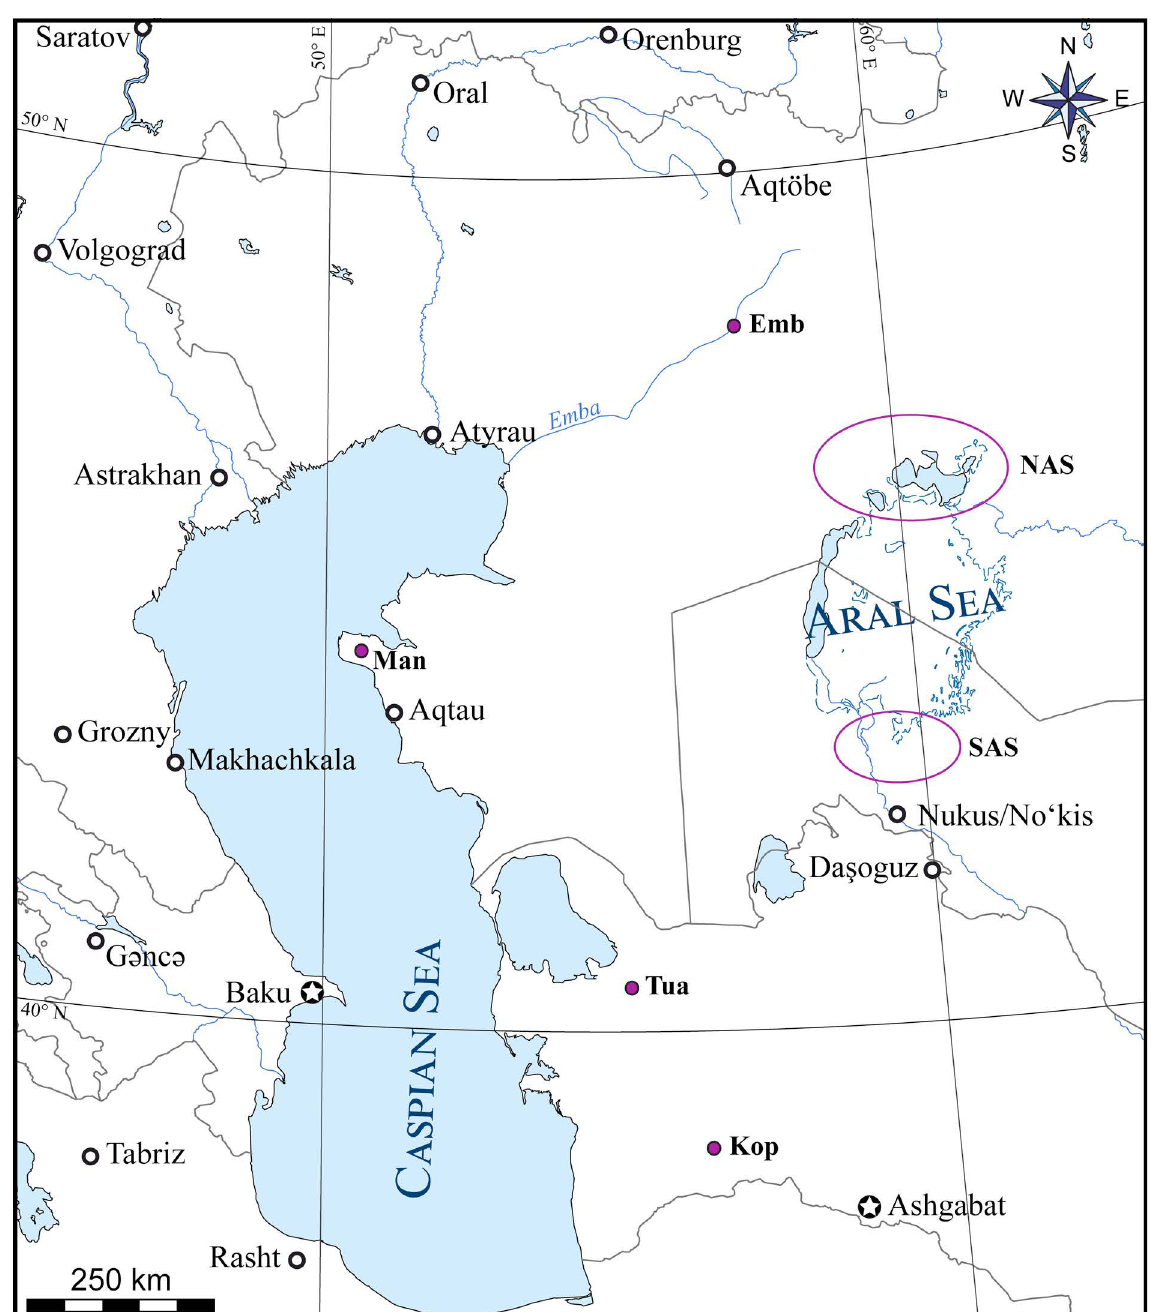
Fig. 2. Map of the Caspian and Aral seas region showing localities of bryozoan material examined or mentioned in this study. Abbreviations: Emb = Emba River, Aqtöbe Region, Kazakhstan; Kop = western Kopetdag, Balkan Region, Turkmenistan; Man = Mangyshlak Peninsula, Mangystau Region, Kazakhstan; NAS = northern Aral Sea region, Kyzylorda Region, Kazakhstan; SAS = southern Aral Sea region north of Chimboy/Shımbay, Republic of Karakalpakstan, Uzbekistan; Tua = Tuarkyr, Balkan Region,